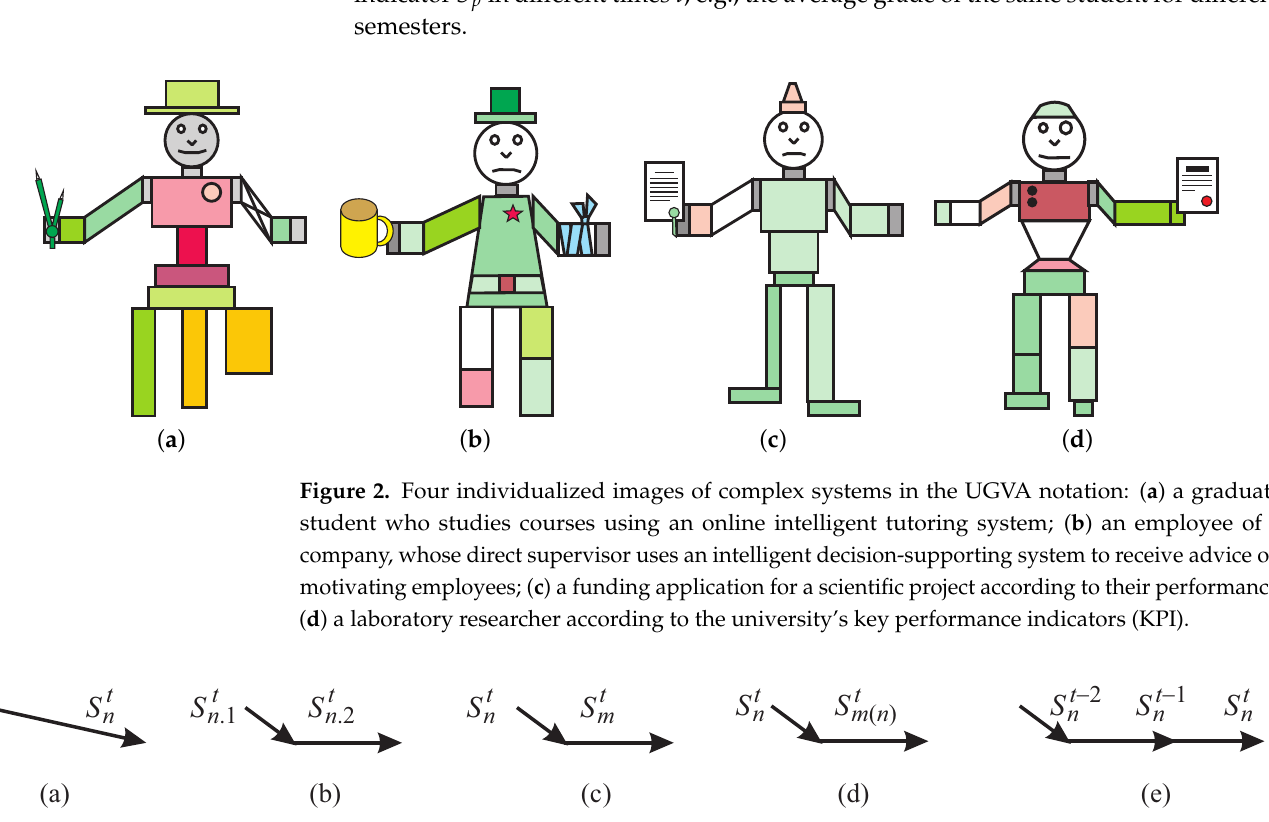
Figure 3. Graphic templates of different axes in UGVA images: ( a ) simple axis (type A ), ( b ) composite structural axis (type B ), ( c ) composite heterogeneous axis (type C ), ( d ) composite cause-effect axis (type D ), ( e ) composite temporal axis (type E ). If a parameter’s value is critically low, the relevant segment of the images can be omitted (which can lead to the omission of an entire axis or only a part of an axis) or marked by a special sign (e.g., in Figure 2a, the parameter coded by left forearm is